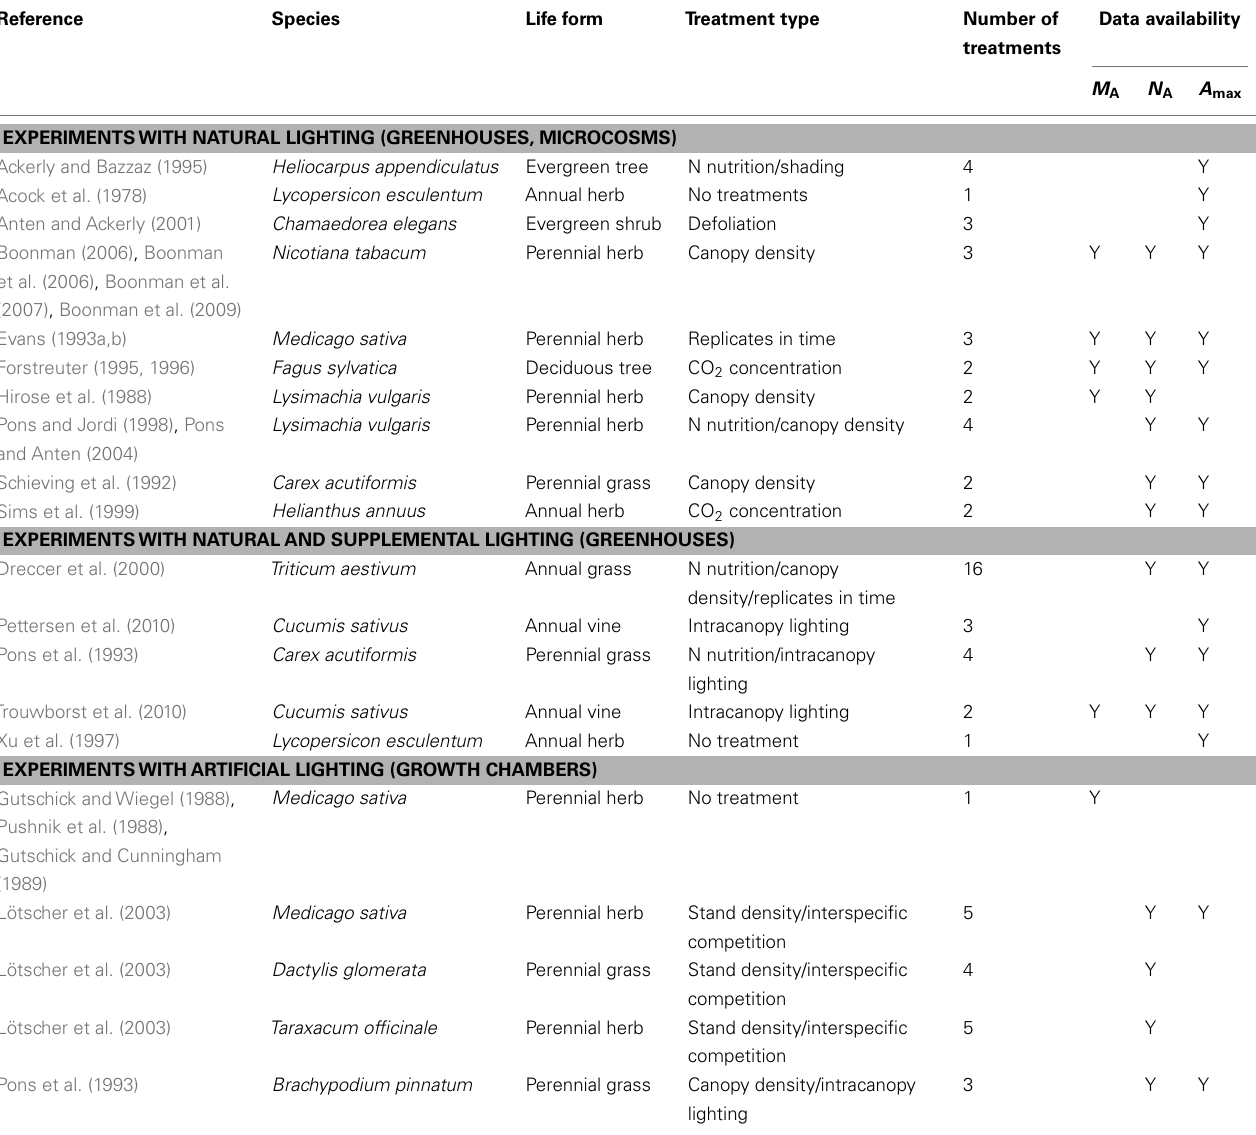
Table 1 |Analyzed studies investigating within-canopy plasticity in foliage dry mass per unit area ( M A ), nitrogen content per area ( N A ), and photosynthetic capacity ( A max ) under different treatments in artificial